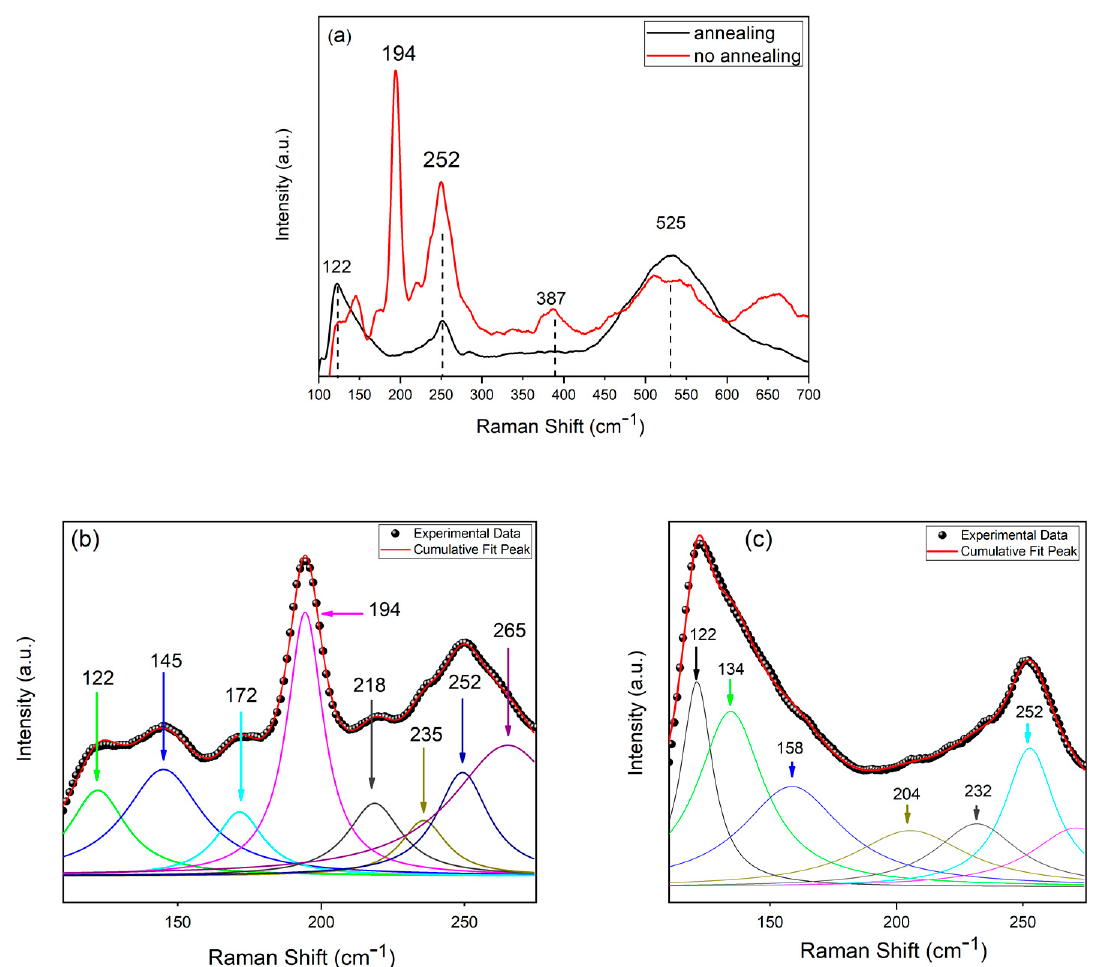
Figure 9. Raman spectrum before and after annealing of the nanowires: ( a ) original spectra, deconvolution of the Raman spectrum of ( b ) no-annealed sample and ( c ) annealed sample. NWs were obtained at pH = 3 with a copper content of 1 mM.